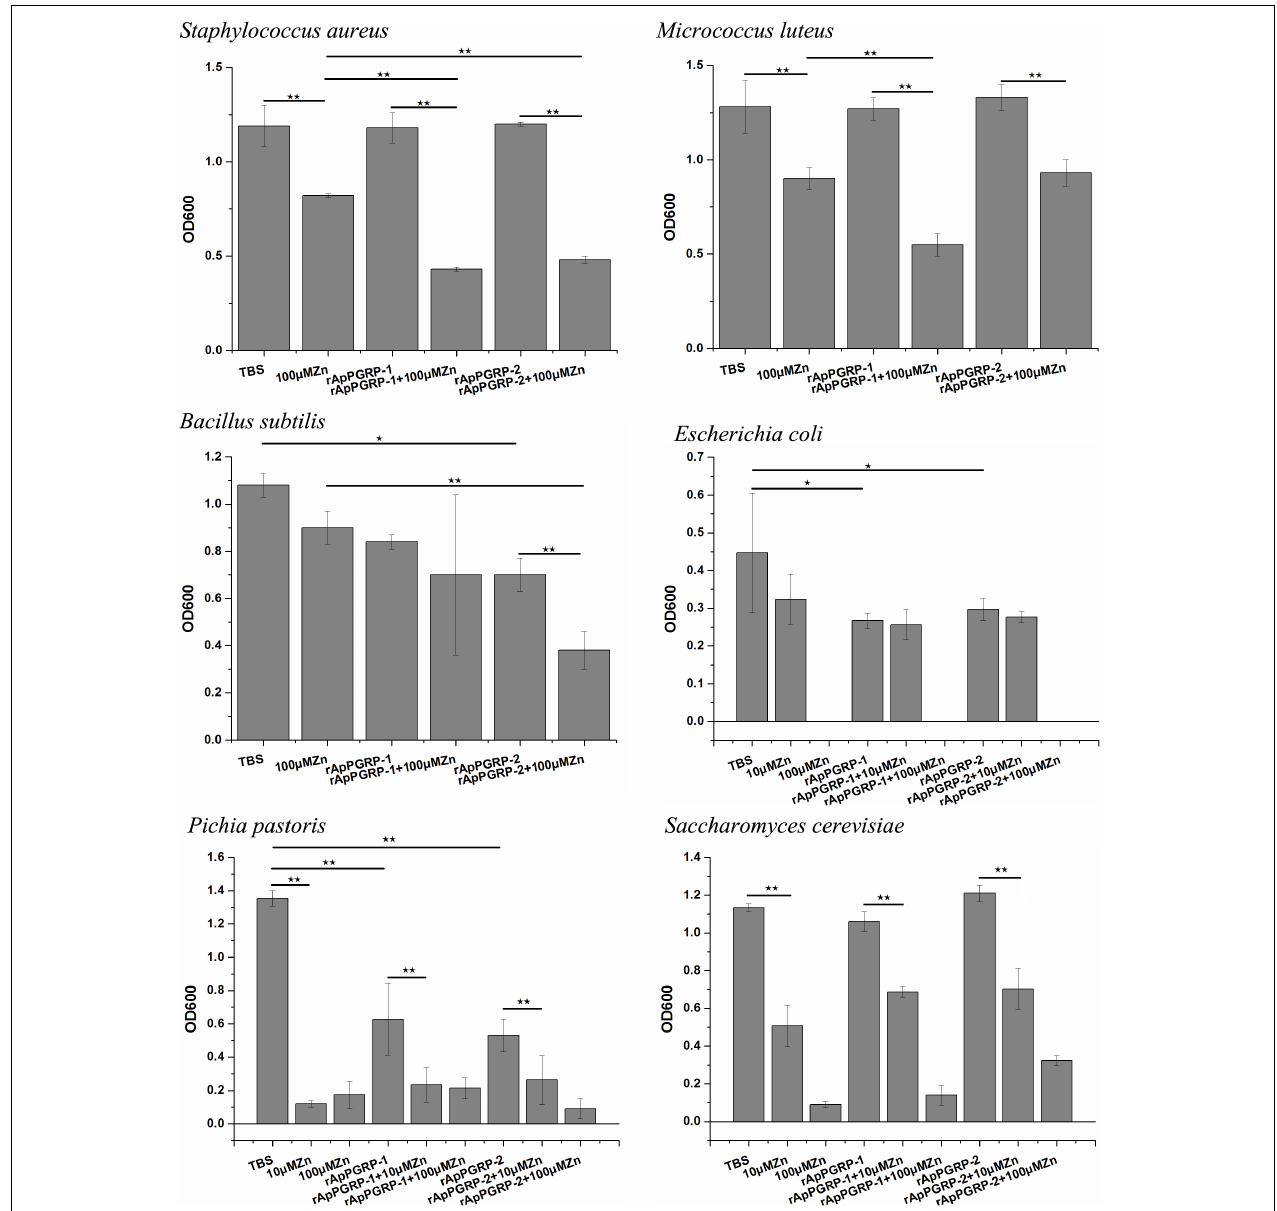
FIGURE 9 | Antimicrobial activity of rApPGRP-1 and -2. (cid:63)(cid:63) indicates P < 0.01, (cid:63) indicates P <